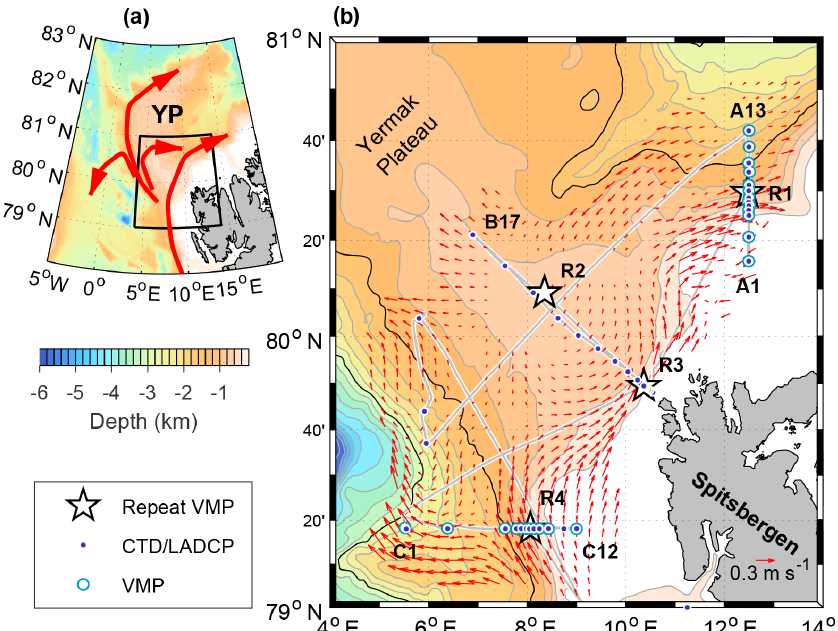
Figure 1. (a) Overview map with the AW circulation patterns (red arrows). The study region zoomed in (b) is indicated by a black rectangle. (b) Station locations of sections A to C and the repeat stations R1 to R4. Selected station names at the edge of sections are marked for reference. Gray lines show the ship track during the cruise. Red arrows show the SADCP data averaged in the upper 500m, objectively interpolated using a covariance function depending on the spatial distance between binned observations and their f/H gradient following Böhme and Send (2005), using a 50km correlation length scale and 5%